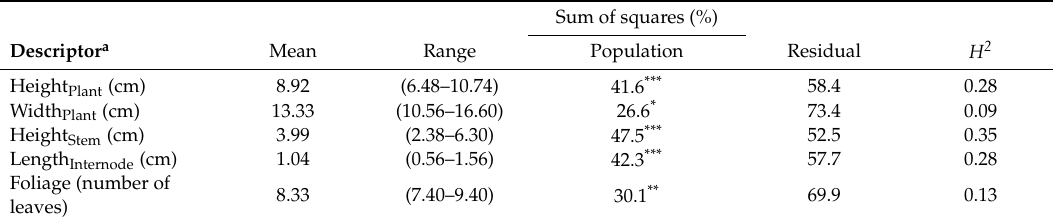
Table 2. Mean value, range, percentage of the total sum of squares for the e ff ects of population and residuals, and broad sense heritability ( H 2 ) for plant quantitative traits ( n = 44). Sum of squares